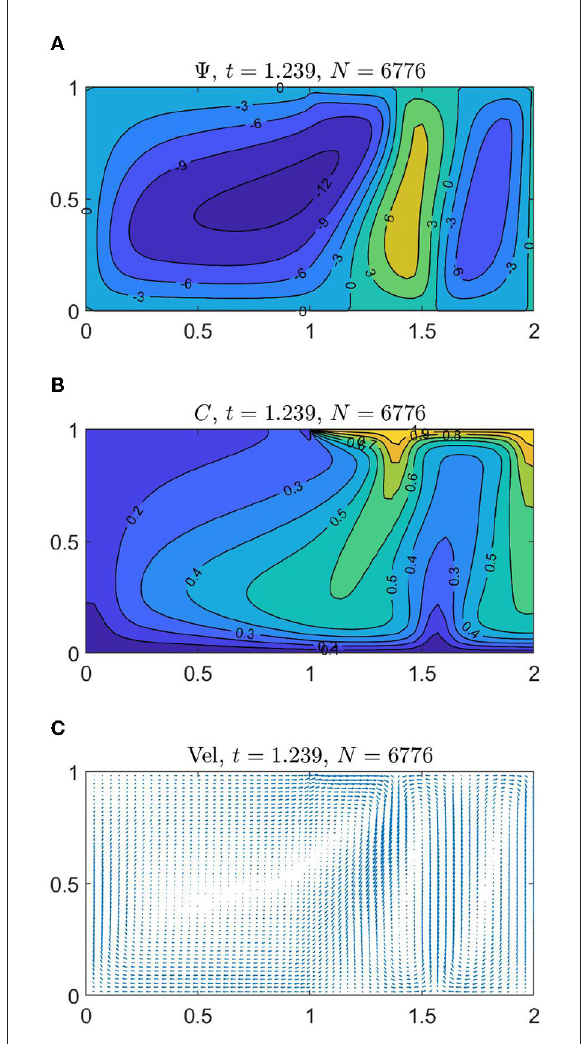
FIGURE14 Steady-state solution to the Elder problem. (A) Streamlines distribution, (B) concentration distribution, (C) velocity vector